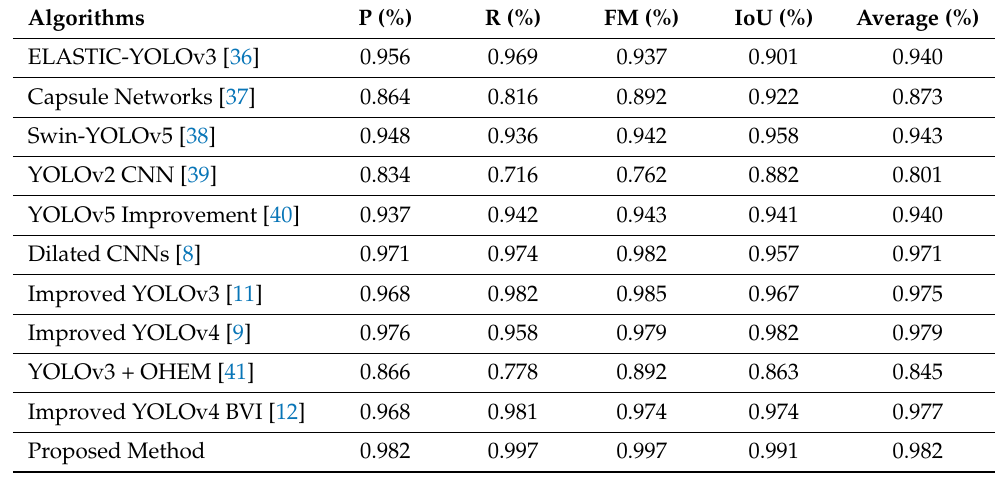
Table 5. Quantitative results of fire identification and notification approaches.